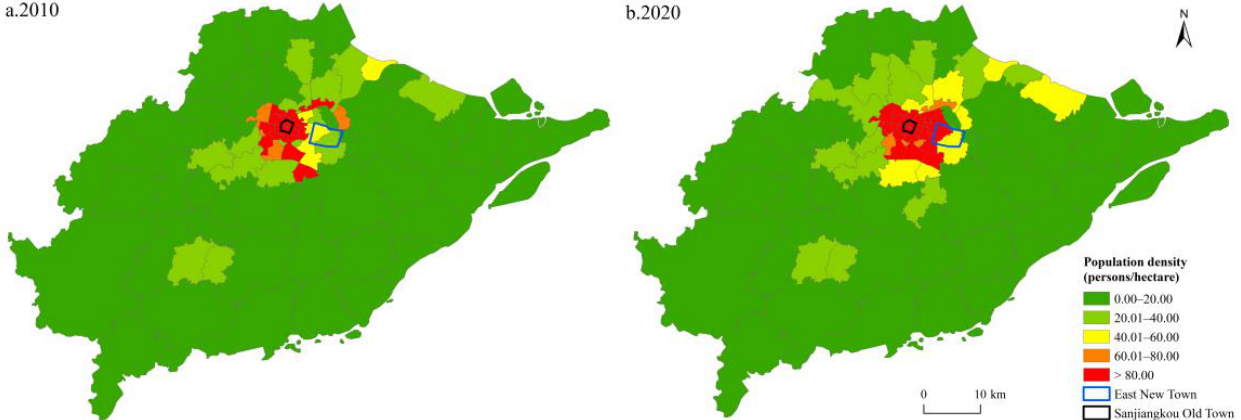
Figure 8. Population density in the central district of Ningbo in ( a ) 2010 and ( b ) 2020. Note: This map is based on the standard map of the Map Technical Review Centre of the Ministry of Natural Resources of China (Number: Zhejiang S (2022)34), with no modifications to the base map. Map-making by the author.